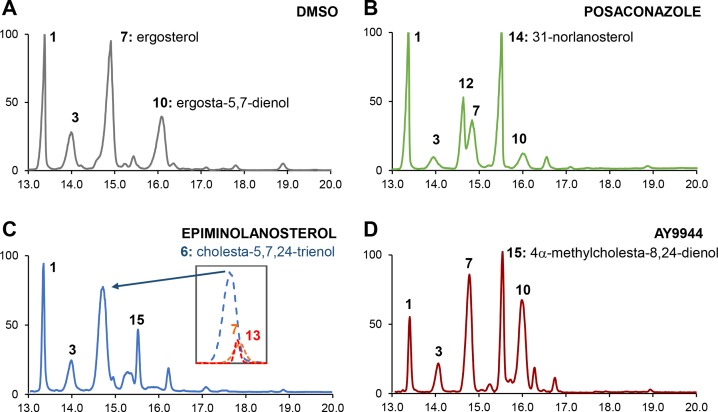
Lipid analysis by GC-MS.Gas chromatography of the total sterol fractions derived from N. fowleri trophozoites treated with (A) 0.5% DMSO, (B) 0.2 μM posaconazole, (C) 5.4 μM epiminolanosterol, and (D) 5.6 μM AY9944. Peaks are labeled with numbers corresponding to metabolites listed in Table 1. Insert in (C) shows deconvolution of the major peak resulting from an overlap of three different sterols: 6, m/z = 349; 7, m/z = 363 and 13, m/z = 400. The color scheme is the same as in Fig 1: CYP51 inhibitor (shown in green), SMT inhibitor (in blue) and ERG2 inhibitor (in dark red).